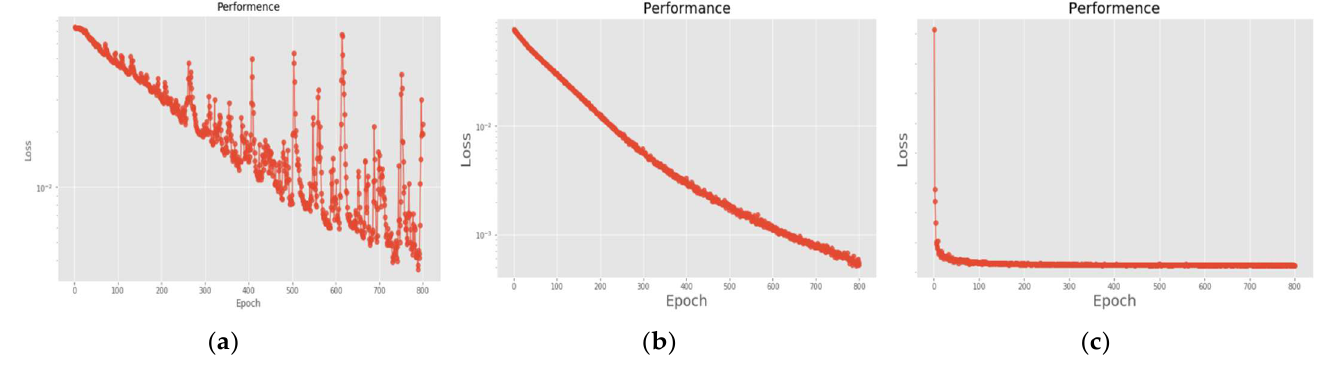
Figure 26. Loss function of LPC 40-features dataset. ( a ) LPC + DNN. ( b ) LPC + CNN. ( c ) LPC + LSTM.